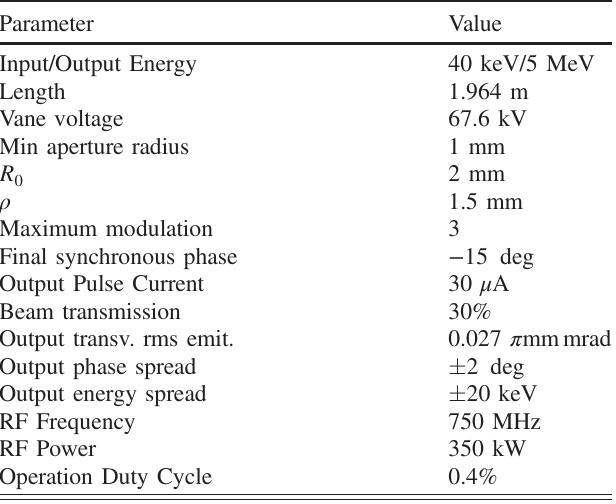
TABLE I. Main RFQ parameters.